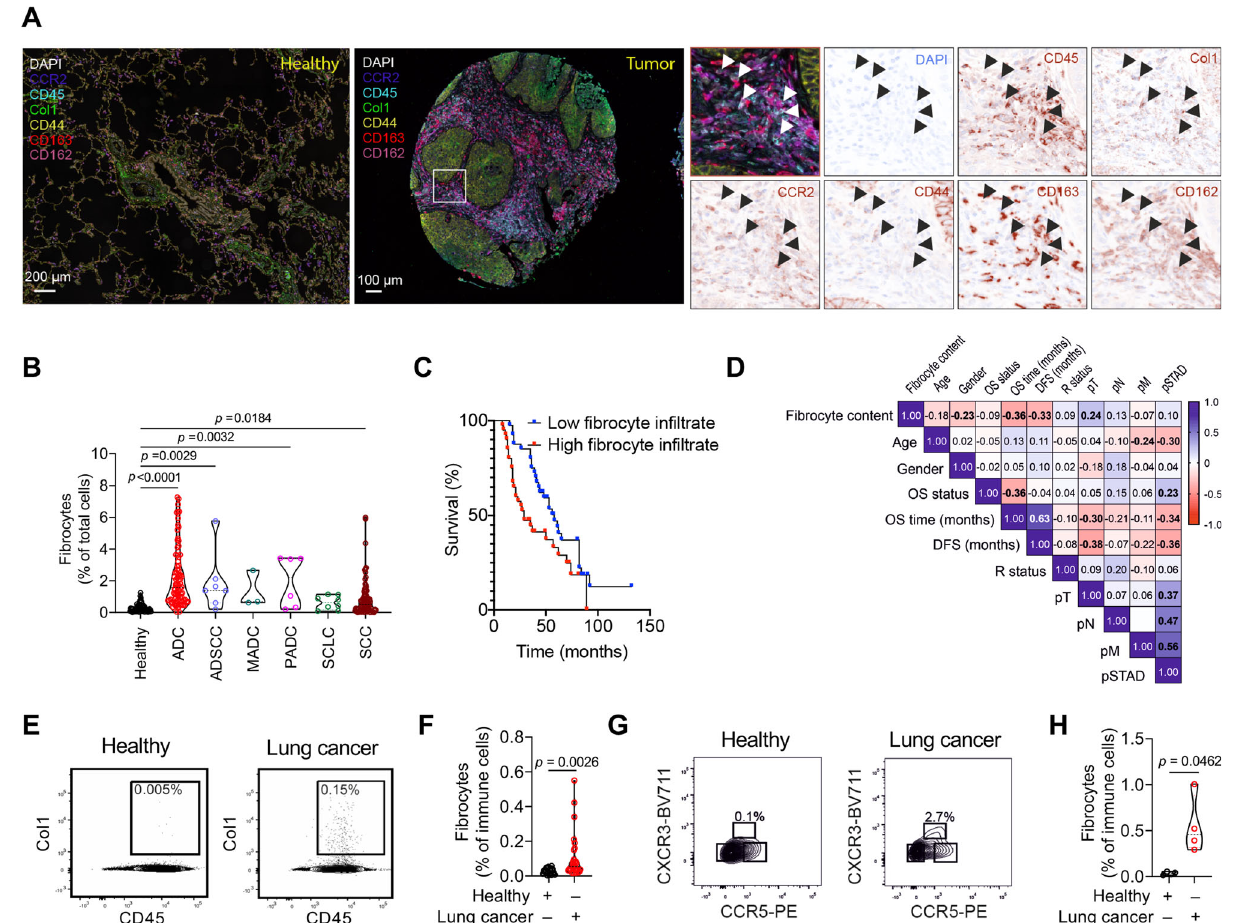
Fig. 4 | High fi brocyte in fi ltrates negatively correlate with overall and disease- free survival time and positively correlate with pT. A , B Representative multi- spectral images of tissue samples from healthy lung and lung tumor tissue (left panel).Tissues were stained with CD45 (cyan) and Col1 (green),CD44 (yellow)and CD163 (red), CCR2 (blue) and CD162 (magenta) antibodies. Nuclei were counter- stained with DAPI (white). Right side panel represents zoomed-in images from the squared area. Arrows indicate fi brocytes (CD45 + Col1 + CD44 + CD163 + CCR2 + CD162 + ) scale bar, 200 µ m (healthy), 100 µ m (tumor). Quanti fi cation of fi brocytes in lung tissue from healthy donors ( n =59) relative to individuals with adenocarcinoma (ADC, n =86), adenosquamous carcinoma (ADSCC, n =7), mucous adenocarci- noma(MADC, n =3), Papillaryadenocarcinoma (PADC, n =6),small cell carcinoma (SCLC, n =8) and squamous cell carcinoma (SCC, n =94) using a TMA. P -values were determined using One-way ANOVA with Fisher ’ s LSD test. C Kaplan-Meier plots reveal patient survival according to fi brocyte in fi ltrates in the lung tumor